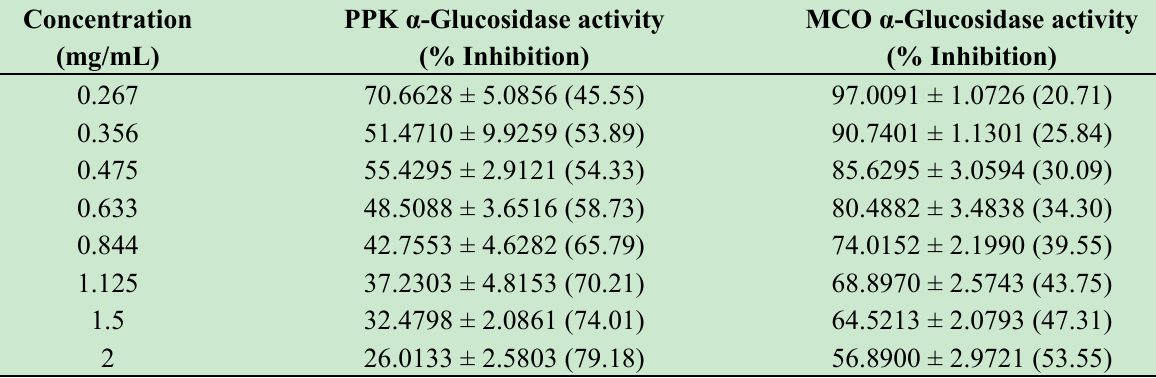
Table 4. Effect of polypeptide-k and oil from Momordica charantia on α -glucosidase activity.